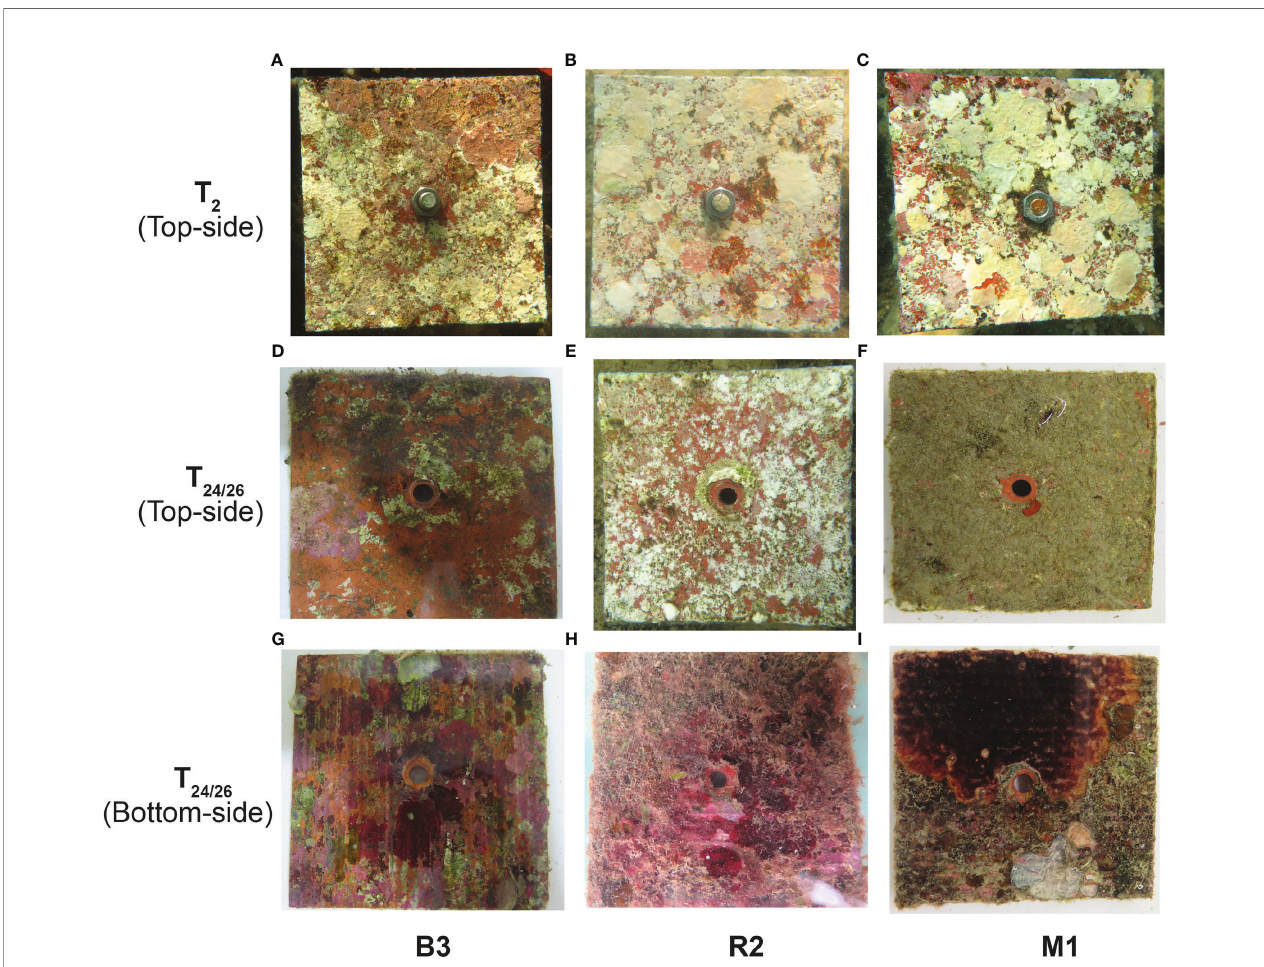
FIGURE 5 | Photos of the tiles (randomly selected) deployed at Bourake ́ B3 (left), station R2 (middle), and station M1 (right). Pictures of the top sides were taken after two months of deployment (T 2 ) (A – C) , and after 24 (D, E) and 26 months of deployment (F) . Pictures of bottom sides of tiles after 24 months (G, H) and ca. 26 months of deployment (I)